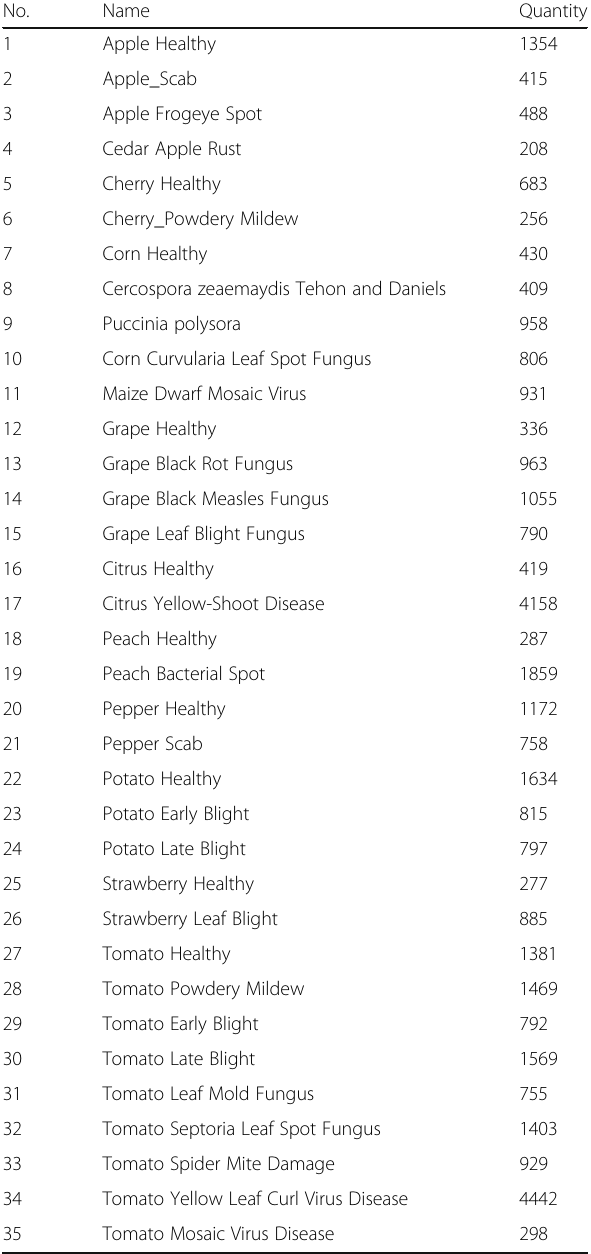
Table 1 Detailed information of sample